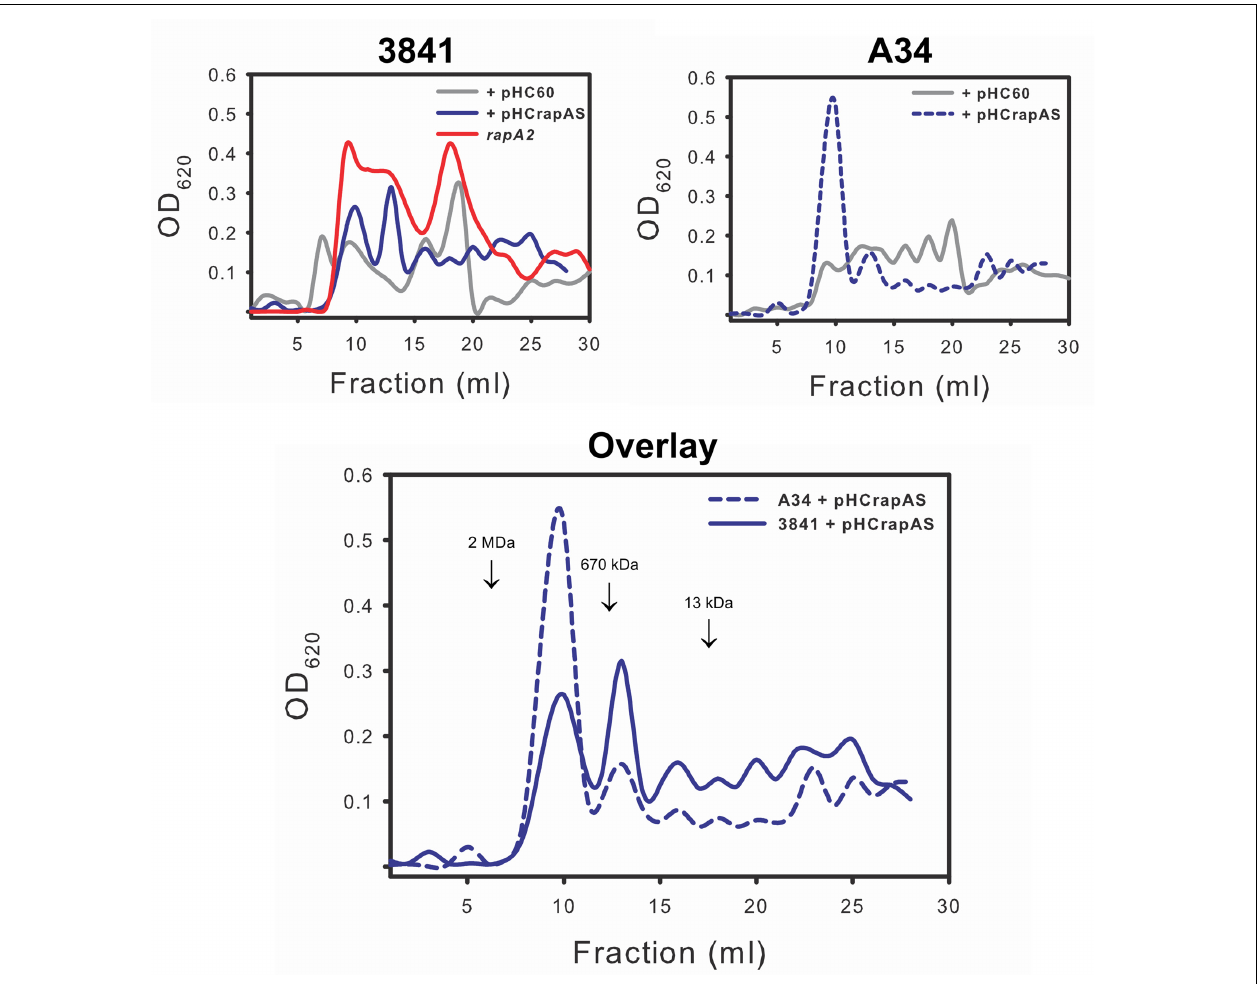
FIGURE 8 | Analysis of the EPS profiles by gel filtration chromatography. EPS produced by strains 3841 and A34 harboring pHC60 or pHCrapAS and the rapA2 mutant were fractionated on a Superose 6 column as described in the text. The elution volume of molecular mass markers is indicated by arrows. The same observation was made in two different and independent